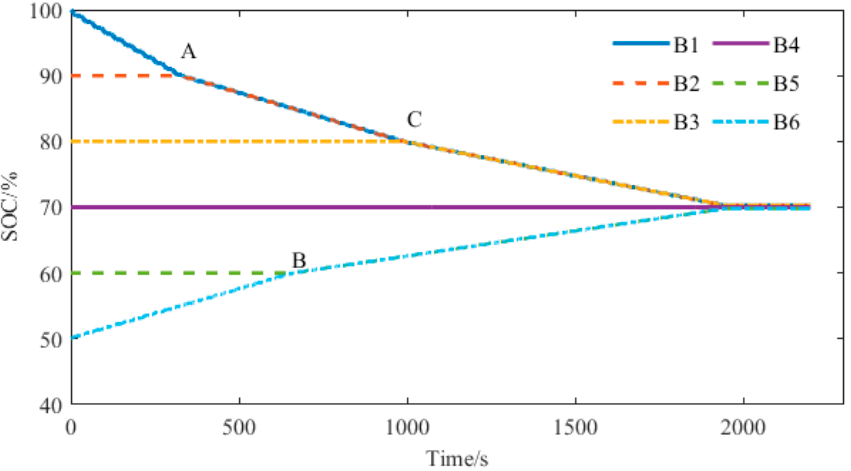
Figure 18. The equilibrium result of the static state.